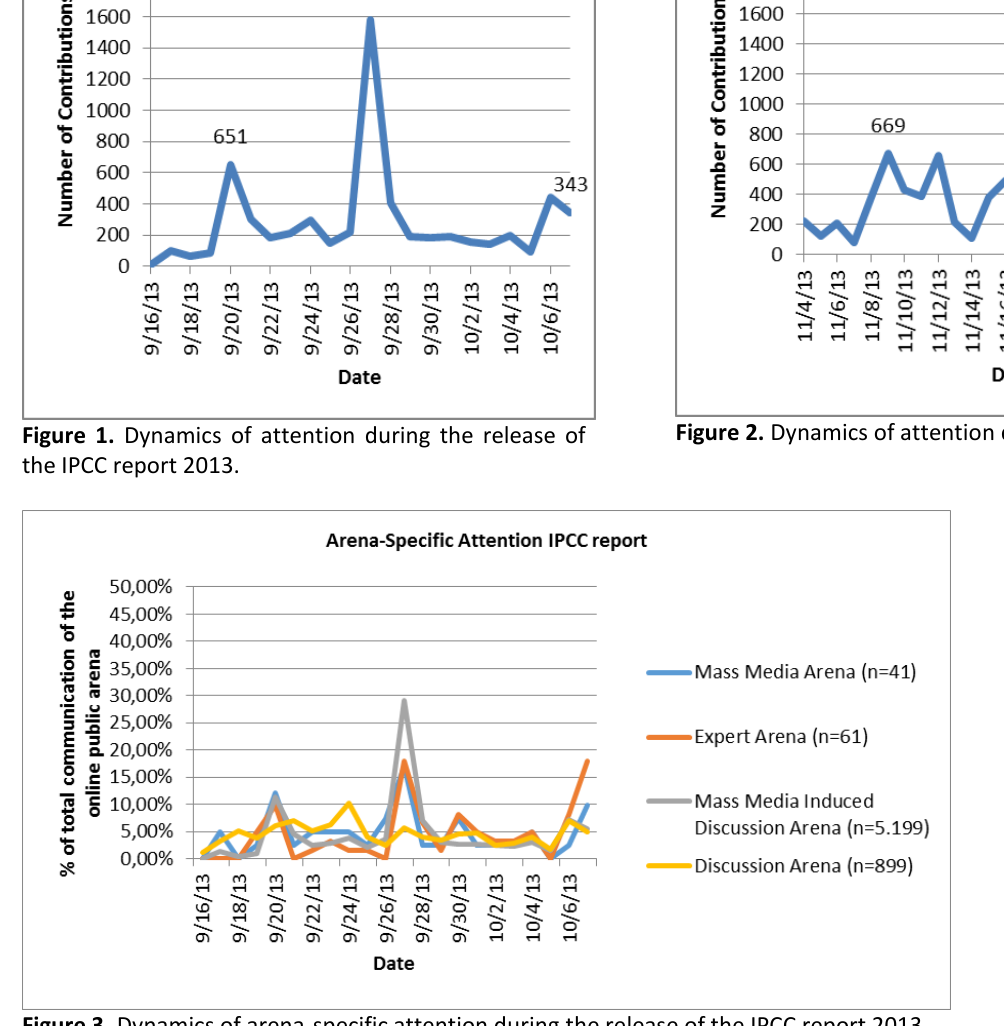
Figure 3. Dynamics of arena-specific attention during the release of the IPCC report 2013.